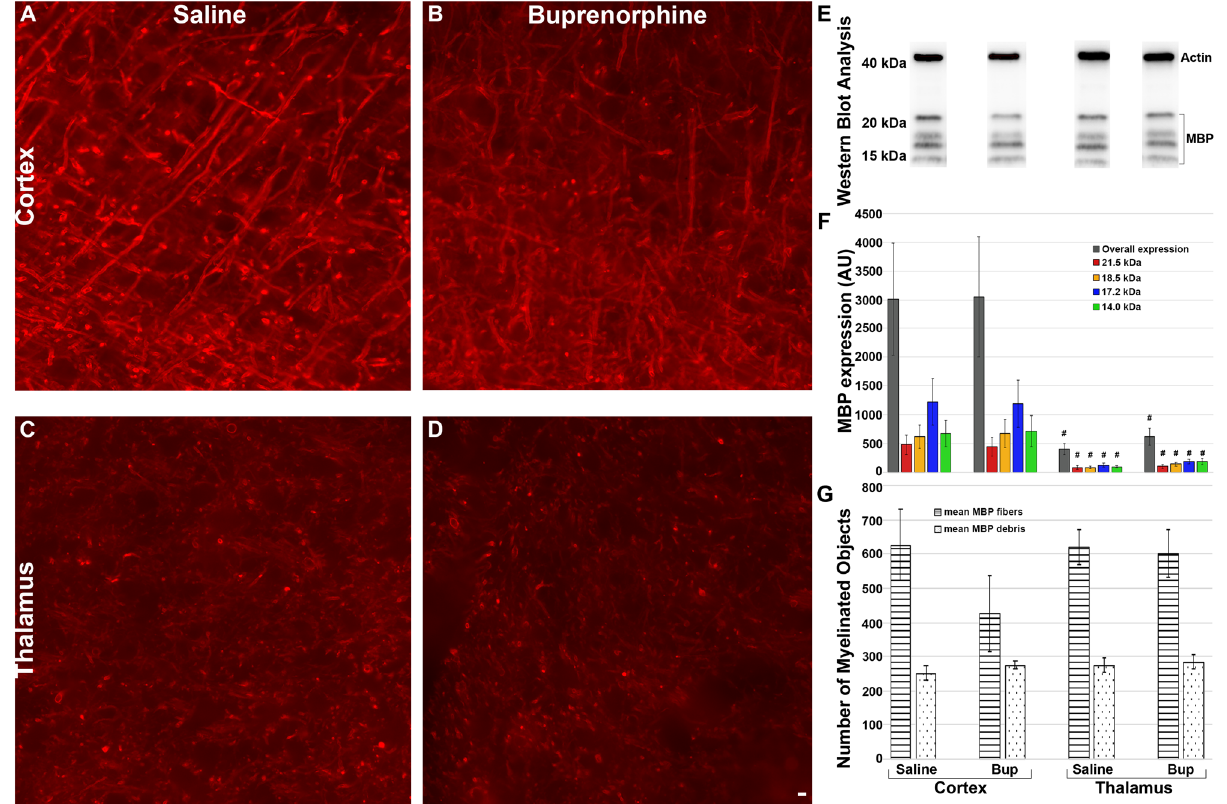
Figure 7. Acute myelin debris and MBP expression was unchanged with Bup treatment but was different between cortex and thalamus. Representative photomicrographs of myelin integrity in ( A , B ) cortex treated with saline or buprenorphine (Bup) and ( C , D ) thalamus treated with saline or Bup, analyzed using ImageJ. Representative bands for ( E ) Western blot analysis of actin protein (band at ~ 40 kDa) and myelin basic protein (MBP; bands at ~ 15–20 kDa). ( F ) Bar graph depicting average overall MBP expression (gray bars), as well as expression of 21.5 kDa (red bars), 18.5 kDa (orange bars), 17.2 kDa (blue bars), and 14.0 kDa (green bars) MBP isoforms in the cortex and thalamus of saline and Bup treated animals. Overall MBP expression and expression of individual MBP isoforms were not significant in either saline or Bup treatment groups. There were, however, significant regional differences with higher MBP expression in the cortex than in the thalamus. ( G ) Bar graph depicting average number of MBP fibers and MBP debris of cortex and thalamus in saline and Bup treated animals. The number of myelinated fibers was consistent between groups, indicating neither region was affected by buprenorphine treatment. Figure was compiled using Adobe Photoshop CS., version 22.0 (2020), San Diego, CA. Treatment differences: regional differences: # p < 0.05 compared to cortex. n = 6 rats/group. Mean ± SEM. Scale = 50